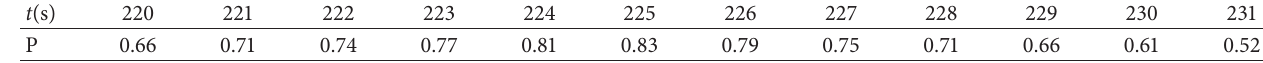
Table 6: Threat probability of the obstacle to the UUV task.